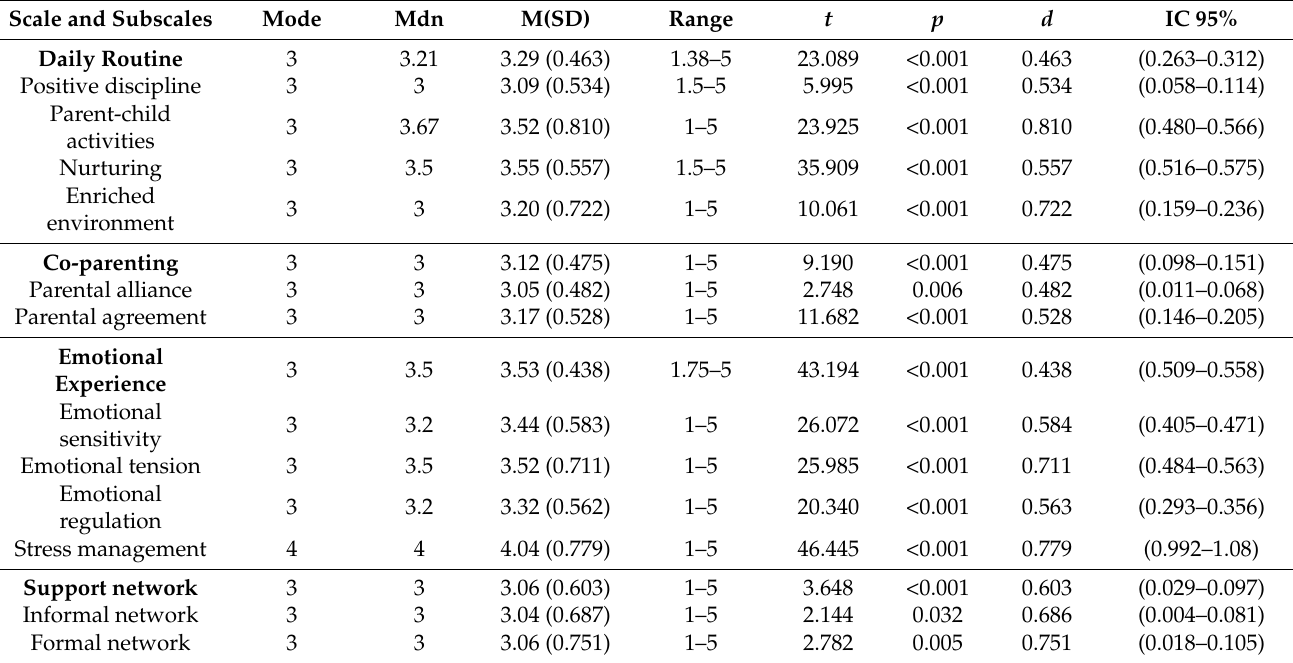
Table 1. Descriptive statistics of scales and subscales related to parenting behaviors and one sample t -test.